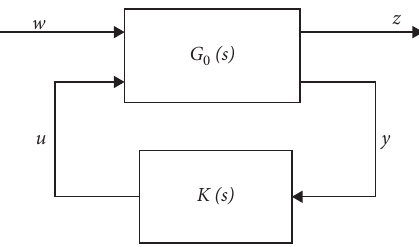
Figure 3: H ∞ standardized control